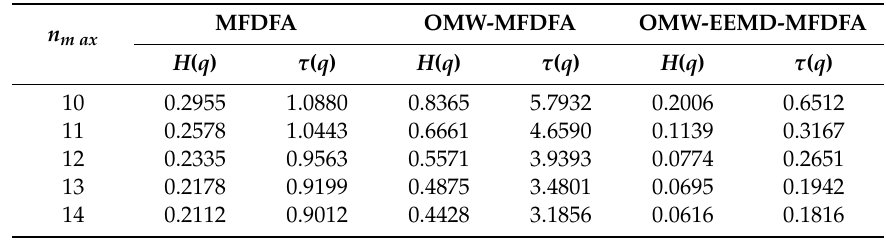
Table 1. The sum of squares for error (SSE) of H ( q ) and τ ( q ) of the three methods with the theoretical values.